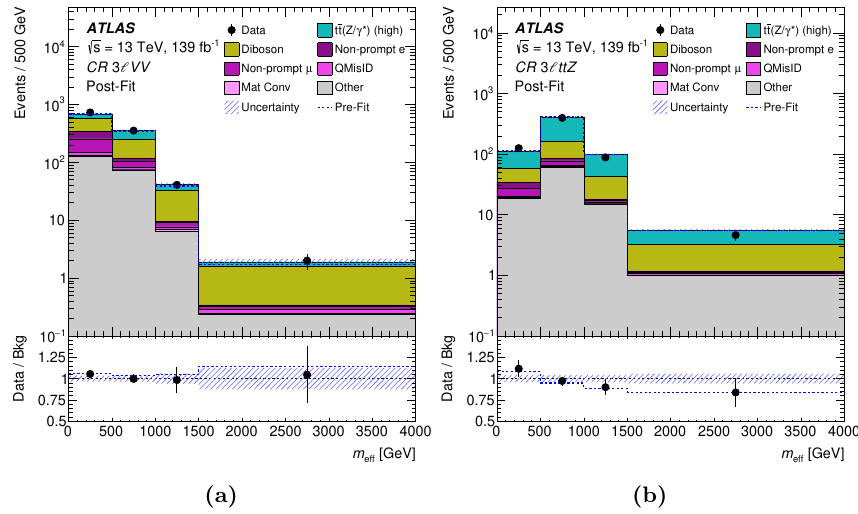
Figure 7. Comparison between data and the background prediction for the m eff distribution in (a) the 3 ‘ VV CR and (b) the 3 ‘ ttZ CR. The background contributions after the likelihood fit to data (“Post-Fit”) under the background-only hypothesis are shown as filled histograms. The total background prediction before the likelihood fit to data (“Pre-Fit”) is shown as a dashed blue histogram in the upper panel. The ratio of the data to the background (“Bkg”) prediction is shown in the lower panel, separately for post-fit background (black points) and pre-fit background (dashed blue line). The size of the combined statistical and systematic uncertainty in the background prediction is indicated by the blue hatched band. The last bin in each figure contains the